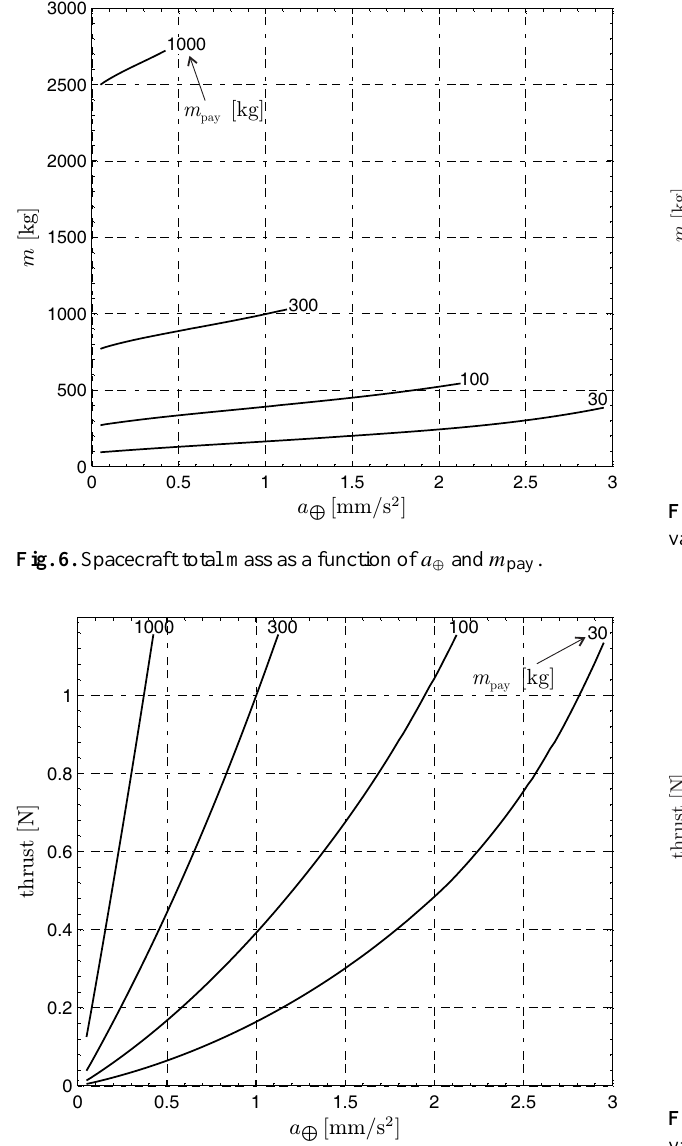
Fig. 7. E-sail thrust at 1AU as a function of a ⊕ and m pay .